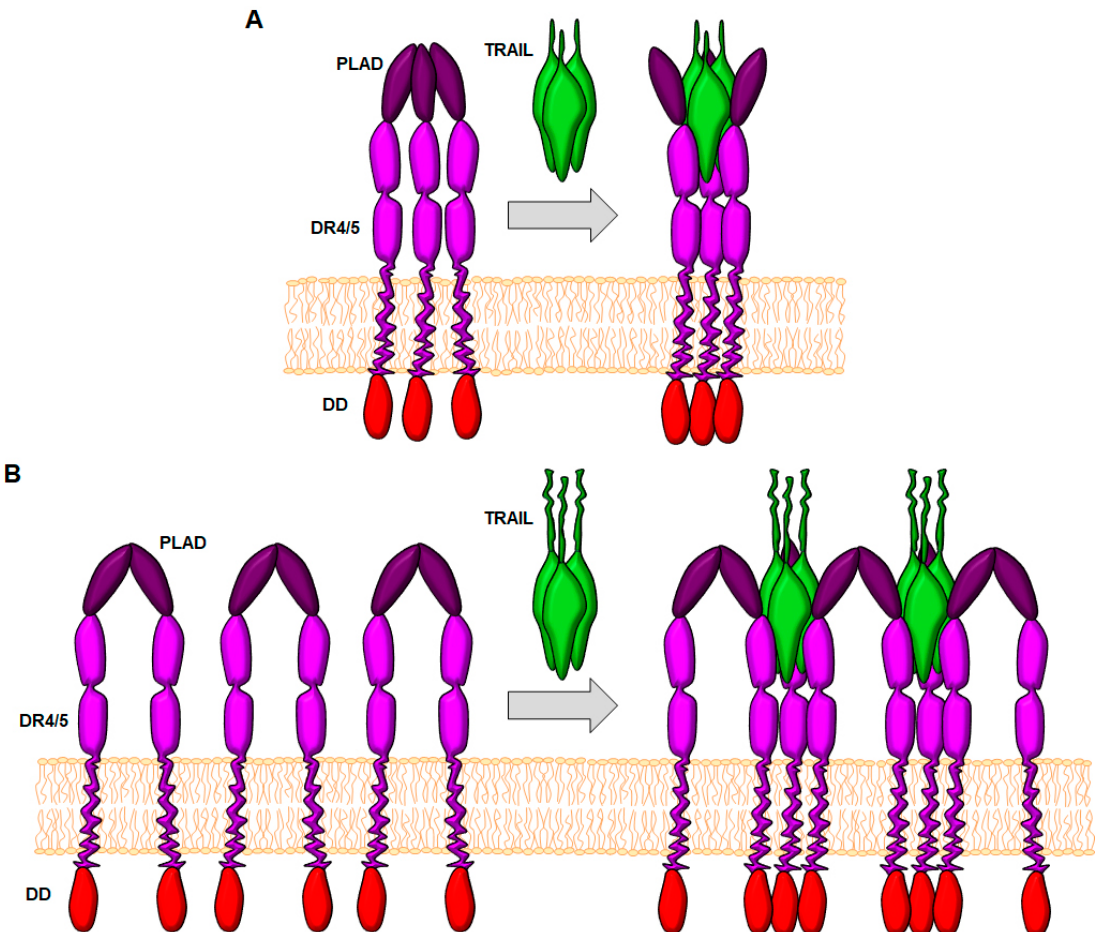
Figure 2. Proposed models for the function of the pre-ligand binding domain (PLAD). ( A ) Model of “conformational change”. In this model, receptors form trimers due to the PLAD, and conformational changes upon TRAIL binding allow juxtaposition of intracellular death domains (DD) of DR4/DR5 receptor molecules. ( B ) Mode of “induction of super-clustering”. In this model, PLAD allows the formation of receptor dimers, and binding of TRAIL promotes a cooperative recruitment of receptors allowing a supra-molecular